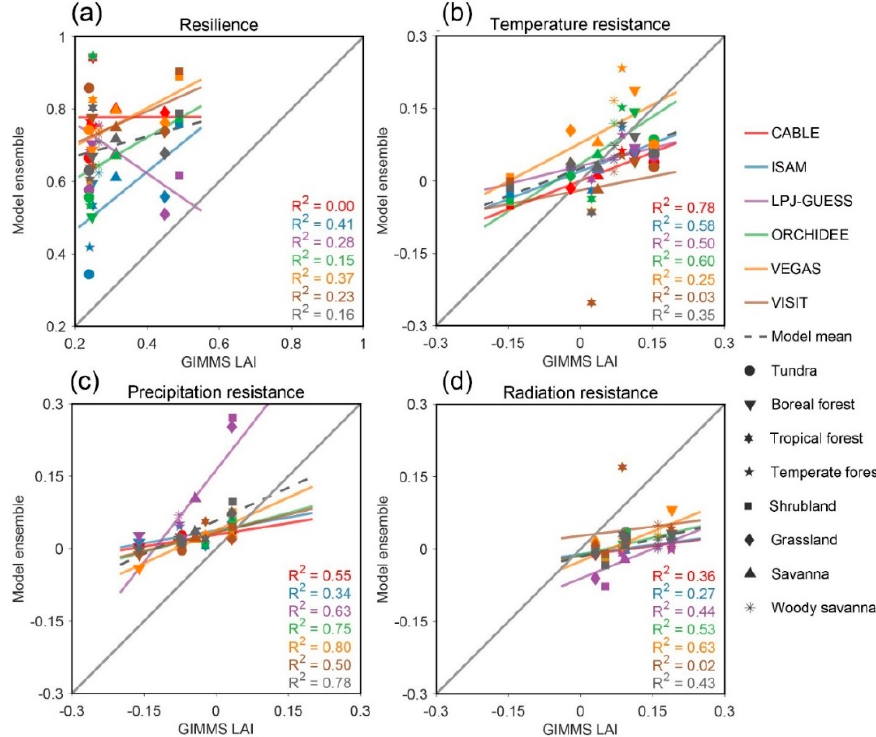
Figure 6. Linear relationship between observation- and model-based vegetation resilience and resistance at the biome scale: ( a ) vegetation resilience; ( b ) temperature resistance; ( c ) precipitation resistance; ( d ) radiation resistance. Different colors represent the six ecosystem models, and different shapes represent the eight biomes. The colored lines represent fitted regression lines.